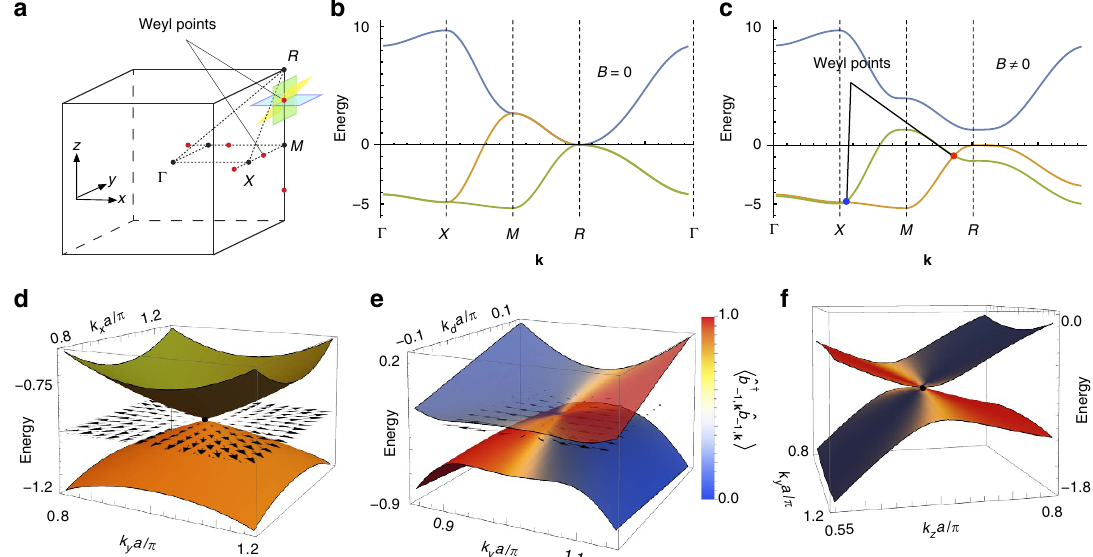
Figure 2 | Weyl quasi-particle dispersion and eigenstates. ( a ) Brillouin zone for the simple cubic lattice. ( b ) Dispersion along high-symmetry lines in the absence of magnetic field (all energies are measured in units of (3/4) g 0 /( k 0 a ) 3 ). ( c ) Dispersion in the presence of magnetic field B ¼ g 0 /( k 0 a ) 3 demonstrating the existence of Weyl nodes (red points) with linear quasiparticle dispersion near them. Each node is characterized by the monopole charge ± 1. In agreement with the fermion doubling theorem 44 (the Nielsen–Ninomiya no-go theorem), there is an even number (six) of Weyl points in the first Brillouin zone. ( d ) Dispersion in the horizontal ( k x (cid:3) k y ) plane (shown by blue colour in panel ( a )) containing the Weyl node near the R point. Quasiparticles in this plane are similar to quasiparticles in graphene and are characterized by a non-trivial Berry phase of p . The arrows show the pseudospin ^ s h i (the Pauli matrices ^ s i act in the space of the angular-momentum projections J z ¼ 0 and J z ¼ (cid:3) 1). ( e ) Dispersion along the (yellow in panel ( a )) plane consisting of p p vectors k ¼ ( p þ k d / ffiffiffi 2 , p þ k y , 0.71 p þ k d / ffiffiffi 2 ) containing the Weyl point. Colour shows the weight of the |1 (cid:3) 1 i state in the quasiparticle eigenstate, and arrows represent the pseudospin ^ s h i . ( f ) Dispersion along the (green in panel ( a )) vertical plane ( k y (cid:3) k z ) containing the Weyl point near the R point. For each momentum k the colour represents the weight of the |1 (cid:3) 1 i